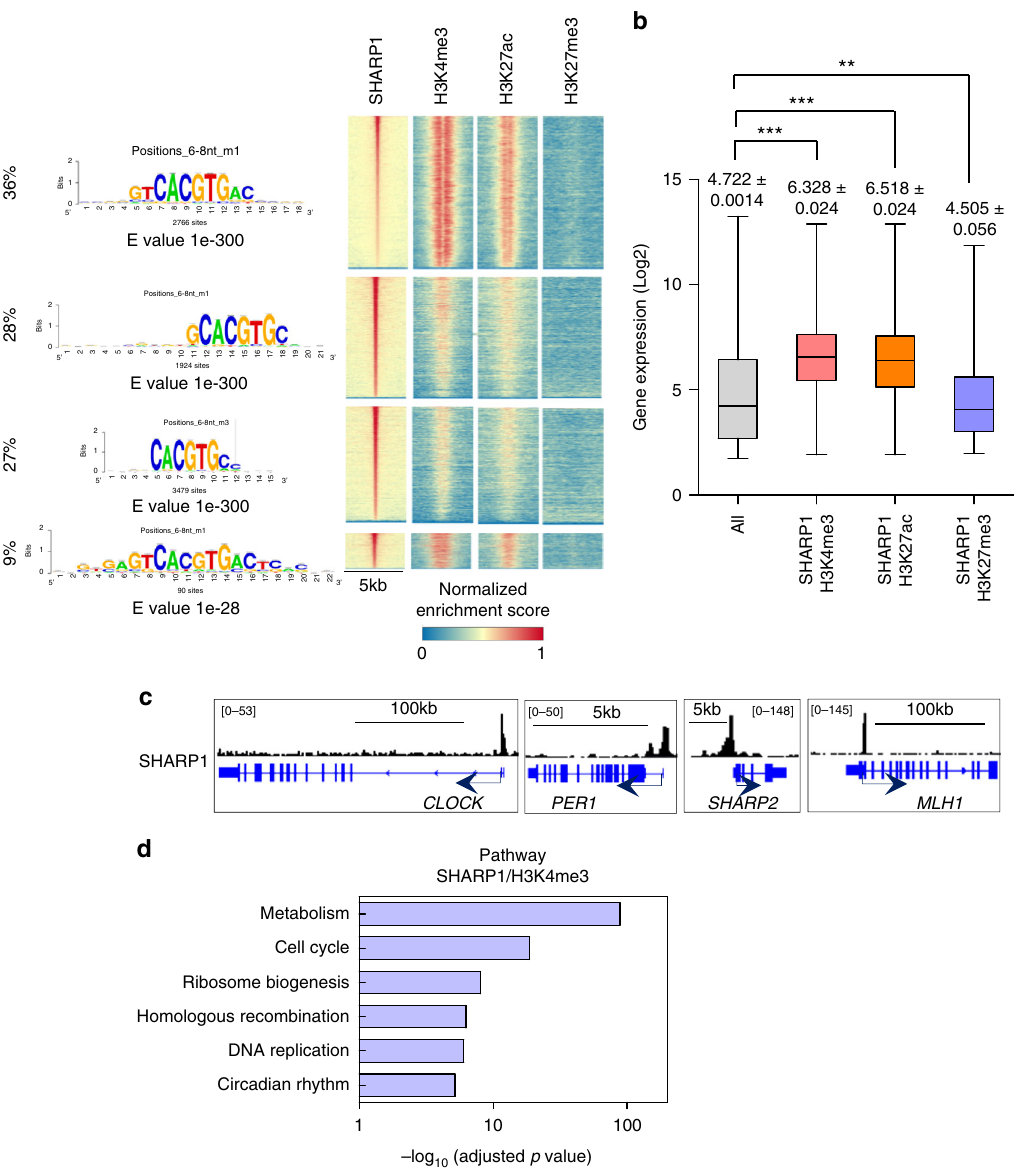
Fig. 6 SHARP1 binds to actively transcribed genes and positively regulates target genes. a Integrated view of SHARP1 binding sites in conjunction with H3K4me3, H3K27ac, and H3K27me3 pro fi les across promoters, introns and intergenic regions. Top enriched motifs within SHARP1 ChIP-seq peaks in ML- 2 cells are shown according to their genomic location discovered by peak-motifs module from the RSAT suite, using oligomer length ranging from 6 to 8 nucleotides and the 'merge lengths for assembly' option. b Box plot showing the expression levels in microarray analysis of ML-2 cells for the all genes (25293 genes) and genes enriched with SHARP1 + H3K4me3 (6459 genes), SHARP1 + H3K27ac (5840 genes), and SHARP1 + H3K27me3 (1055 genes) identi fi ed in ChIP-seq analysis. The box extends from the 25 th to 75 th percentiles and the whisker extends from the minimum level to the maximum. Median value is plotted in the box. c Representative SHARP1 binding peaks in the known target gene loci (circadian clock genes and MLH1 ). d Pathway analysis for the genes in the SHARP1 and H3K4me3 co-bounded regions within the promoter and gene